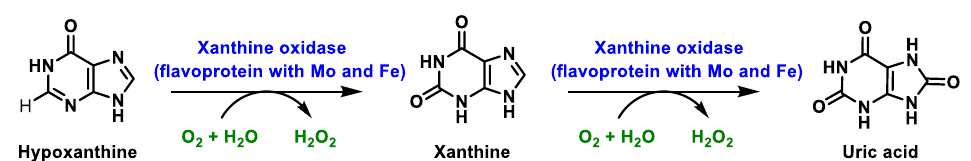
Figure 6. Xanthine oxidase XOR generates superoxide radical ion and hydrogen peroxide. In mammals, this enzyme catalyses the hydroxylation of hypoxanthine to xanthine and xanthine to uric acid [27]. XOR uses hypoxanthine and oxygen (as an electron acceptor) to give rise to xanthine (eventually uric acid) and superoxide radical. In the active form of XOR, Mo forms two single bonds with the sulphur atom (thiol groups), two bonds with the oxygen atom (one with the oxo group and one with the hydroxyl group) and the fifth coordination position is occupied by a double bond with the sulphur atom. XOR converts xanthine to uric acid, Figure 7, the end product of the catabolism of purine bases in humans.